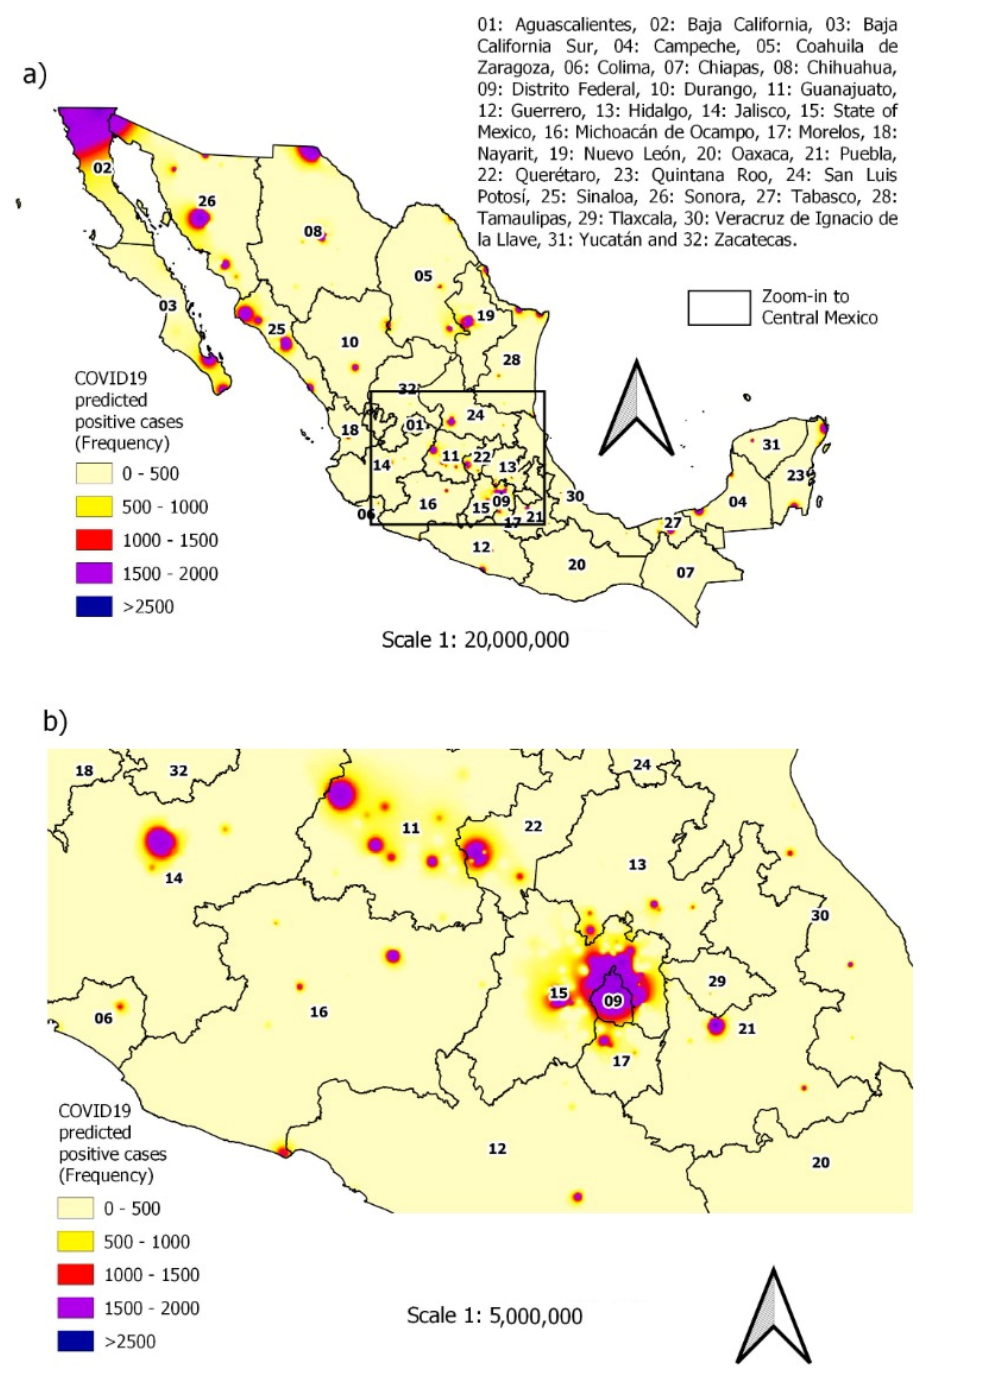
Figure 11. Predicted spatial distribution of COVID-19 occurrence from February 2020 to April 2022: ( a ) average actual occurrence with multivariate logistic regression; ( b ) zoom-in to Central